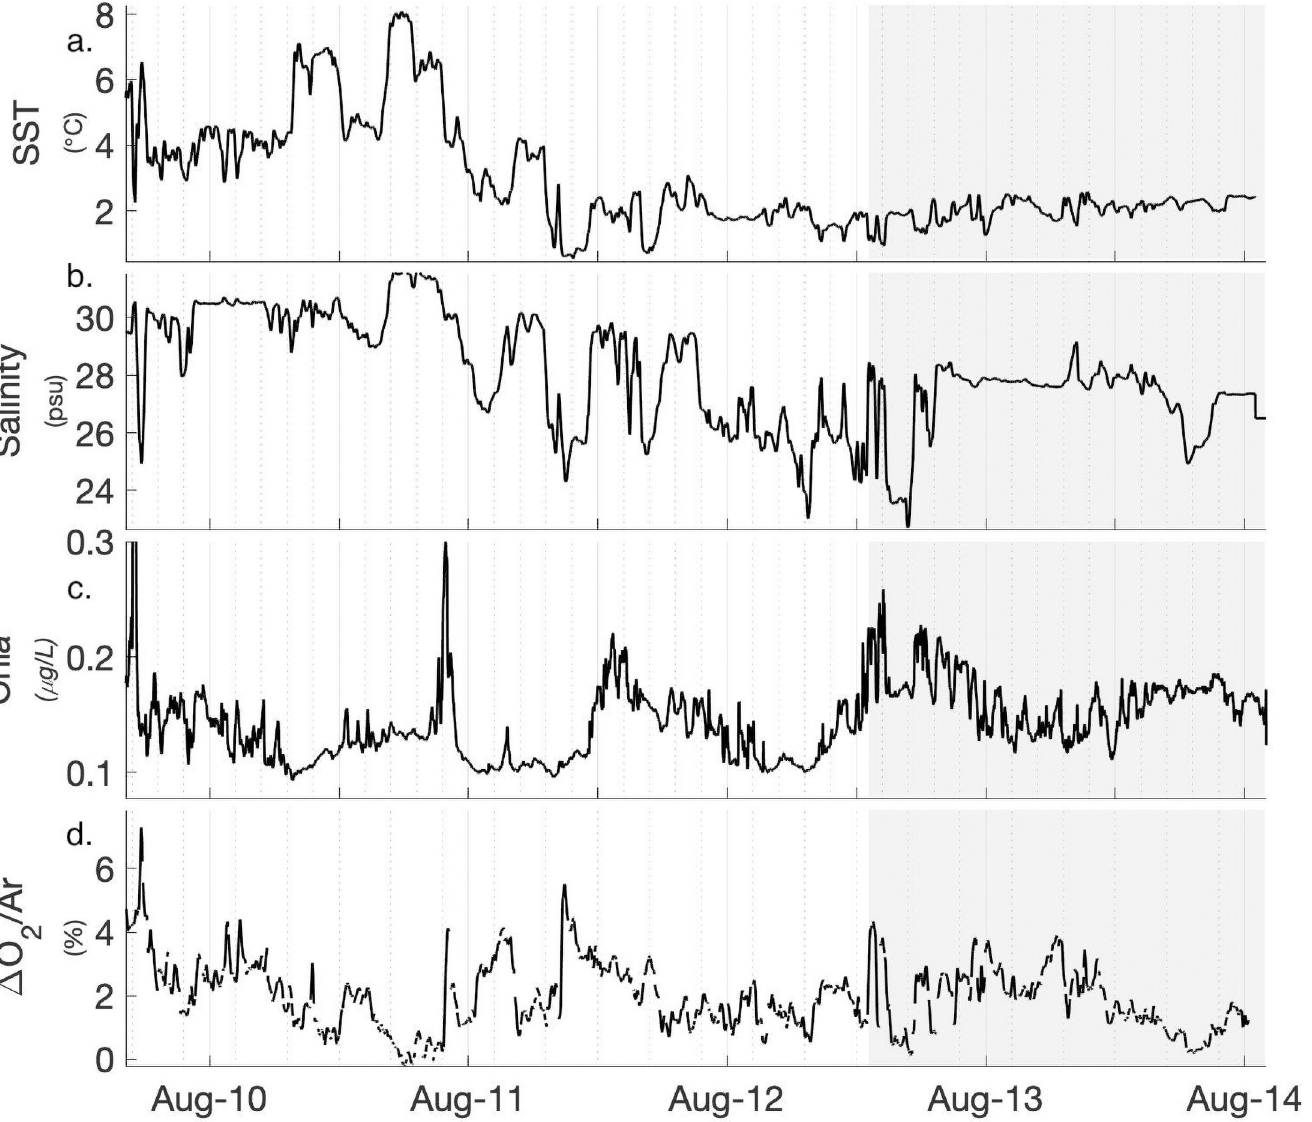
Fig 2. Summary of oceanographic conditions. Hydrographic conditions, phytoplankton biomass and biological oxygen saturation measured in surface waters ( * 7 m depth) along the cruise track. Shaded area on Aug. 13–14 marks measurements made in Barrow Strait.